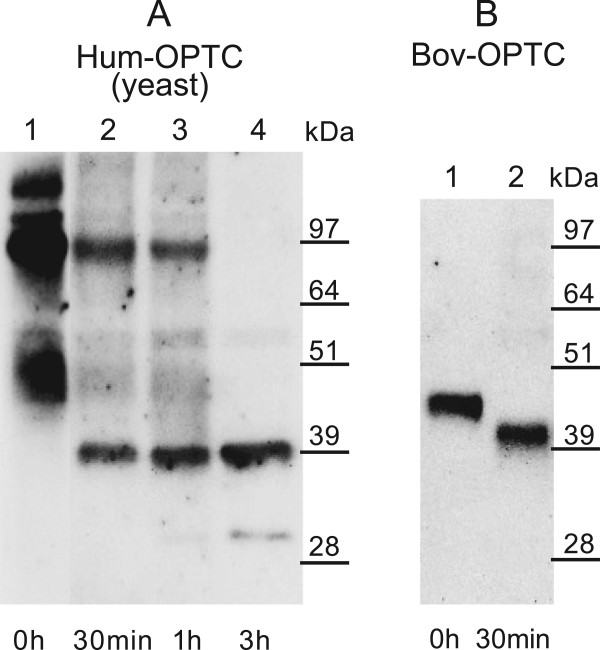
Western blot of human and bovine OPTC after chemical deglycosylation by TMFS. A) recombinant human OPTC produced in yeast and B) recombinant bovine OPTC. Western blot was performed using a C-terminal anti-OPTC pAb. Lane 1: Untreated recombinant OPTC. Lane 2: Recombinant OPTC treated with TFMS for 30 min. Lanes 3 and 4: Recombinant OPTC treated with TFMS and anisole for 1 and 3 h, respectively. Complete removal of the carbohydrate structures yielded a 39 kDa and a 40–42 kDa band in the human and bovine OPTC, respectively.